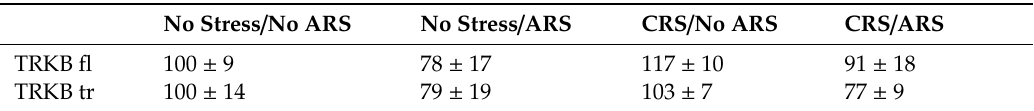
Table 1. Analysis of TRKB receptor (full-length and truncated form) protein levels in the whole homogenate of the prefrontal cortex of chronically stressed rats (CRS) exposed to an acute challenge (ARS) after 3 weeks of washout (wash). The data, expressed as a percent change of No stress / No ARS animals, are the mean ± SEM. No Stress / No ARS No Stress / ARS CRS / No ARS CRS / ARS TRKB fl 100 ± 9 78 ± 17 117 ± 10 91 ± 18 TRKB tr 100 ± 14 79 ± 19 103 ± 7 77 ± 9